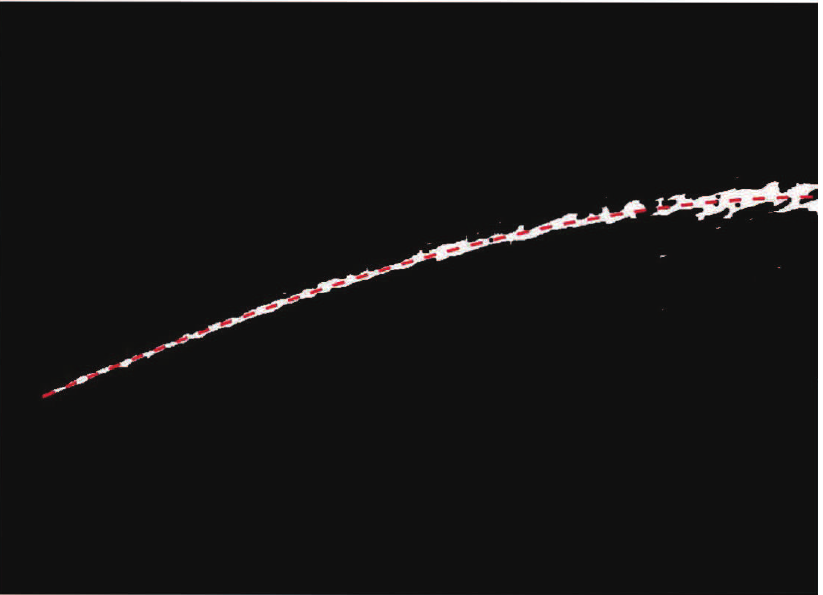
Figure 7. The jet trajectory curve based on the proposed mean position